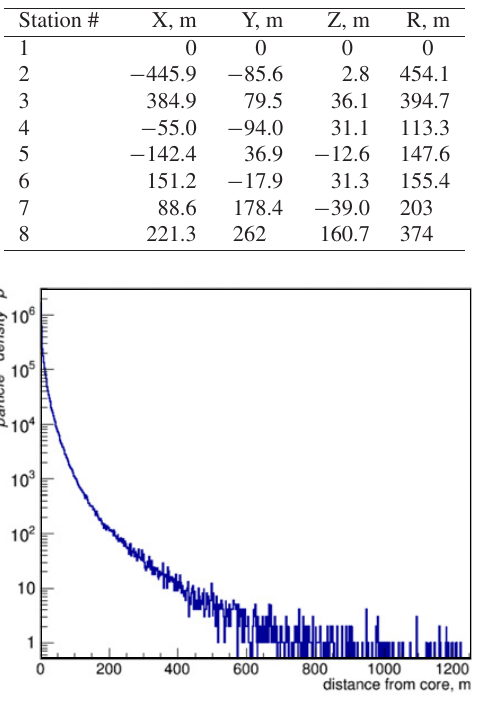
Figure 2. Charged particles density vs. distance from EAS core.